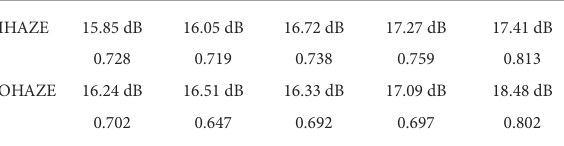
TABLE 5 Results of ablation